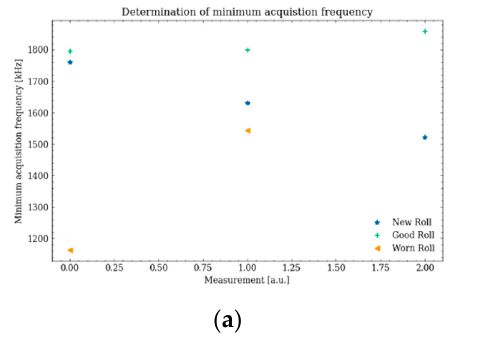
Figure 9. Dependence of the calculated signal-to-noise ratio from the acquisition frequency. ( a ): The minimum acquisition frequency for each dataset. ( b ): Exemplary plot of the relative deviation of the SNR from SNR@100kHz vs signal acquisition frequency in a range from 500 Hz to 100 kHz. The plots of the other measurements show a similar behavior. Source: own-elaboration.